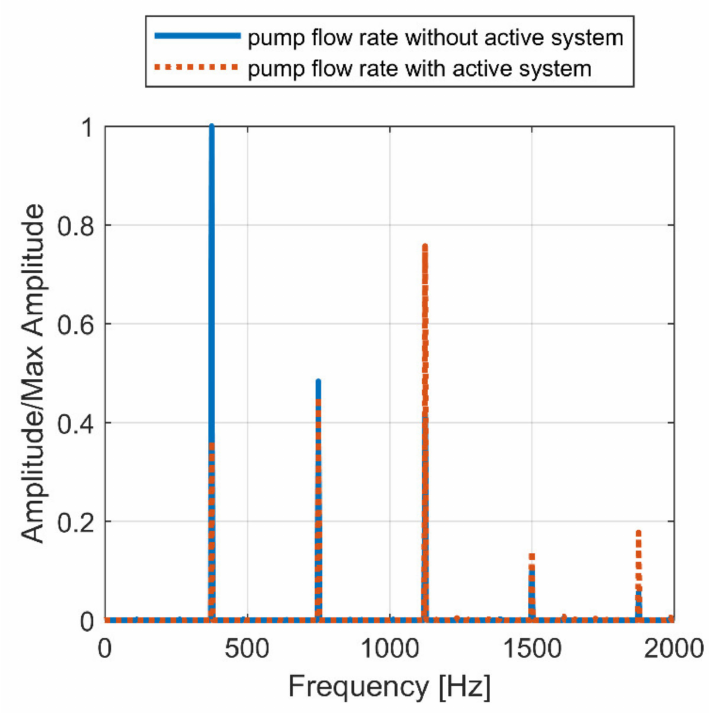
Figure 19. Limited current simulation, section 2: flow ripple FFT at 135 bar, 2500 rpm, 100% swash plate inclination.